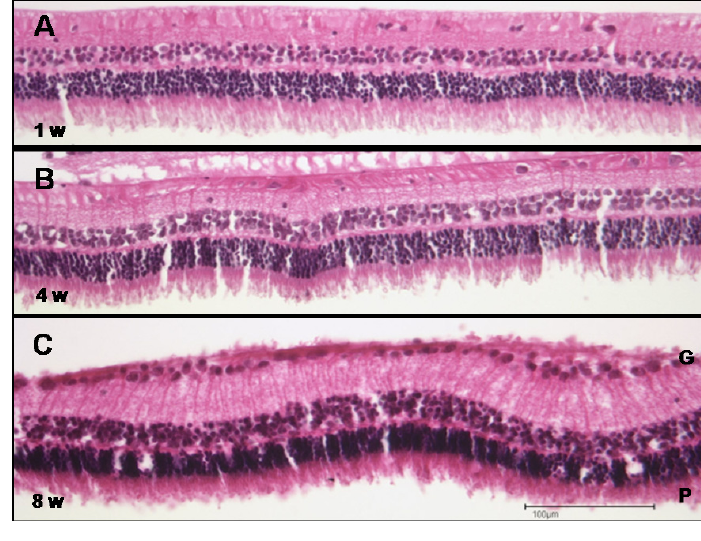
Figure 13. Histology of the retina from eyes implanted with PEA fibrils intravitreally. At ( A ) one, ( B ) four, and ( C ) eight weeks after intravitreal implantation the retina is normal with no evidence of any alteration. Note a normal and intact photoreceptor layer (“P”) and ganglion cell layer (“G”). Scale bar, 100 µm. Magnification,